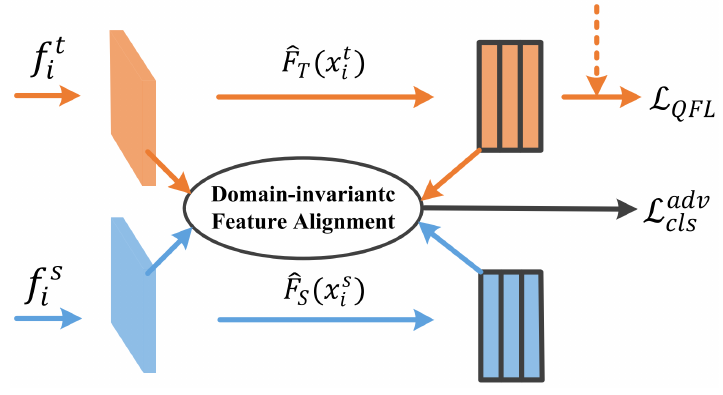
Figure 4. The feature alignment